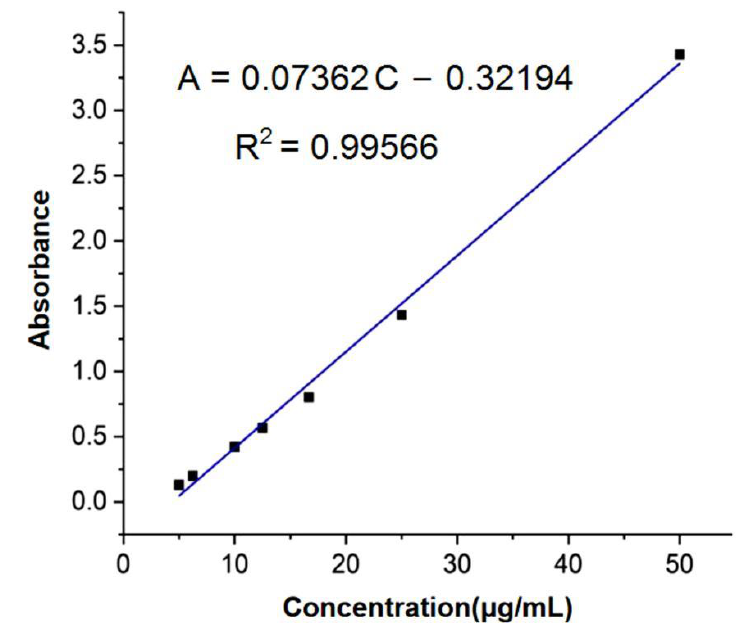
Figure 9. The standard curve of FA.